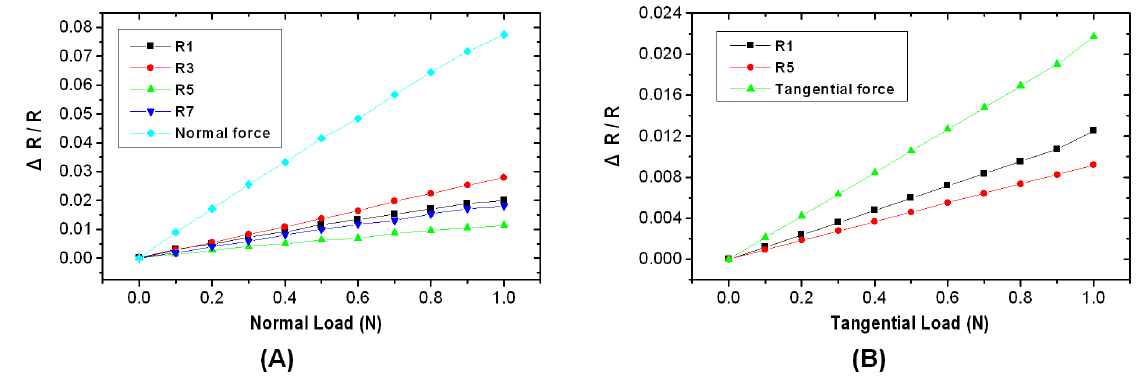
Figure 8. Normalized evaluation results change in output resistance under ( A ) normal loading F and ( B ) tangential loading F z